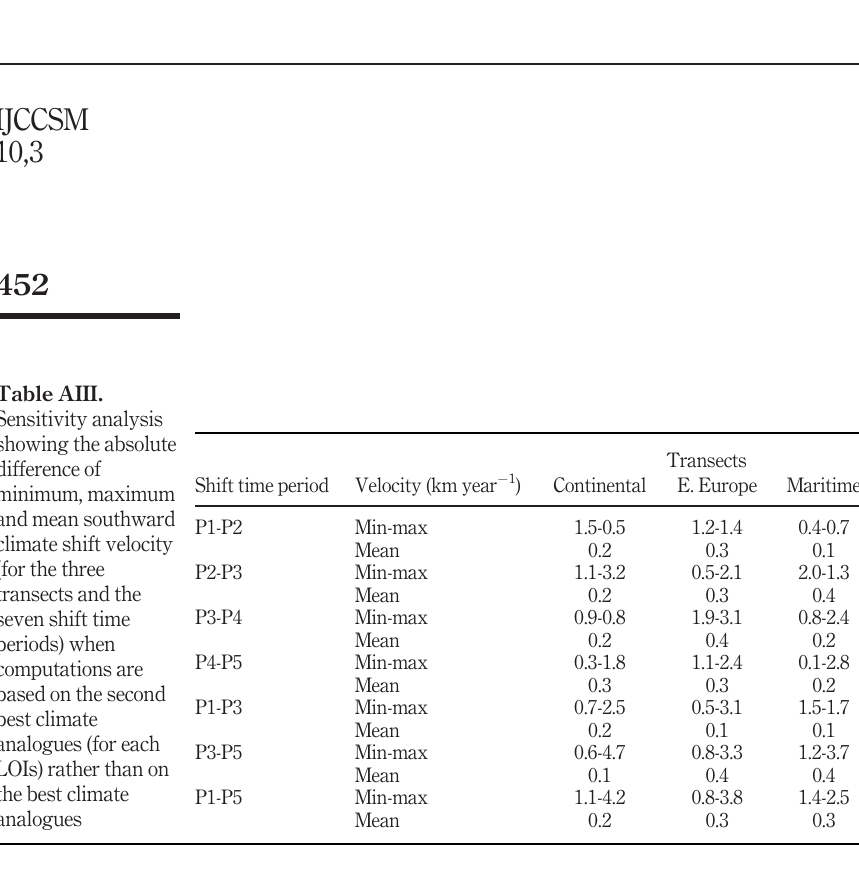
Table AIV. Return periods in years of mean daily maximum temperatures for Aarhus (Denmark), Berlin (Germany) and Warsaw (Poland) and their respective climate analogues for the four future